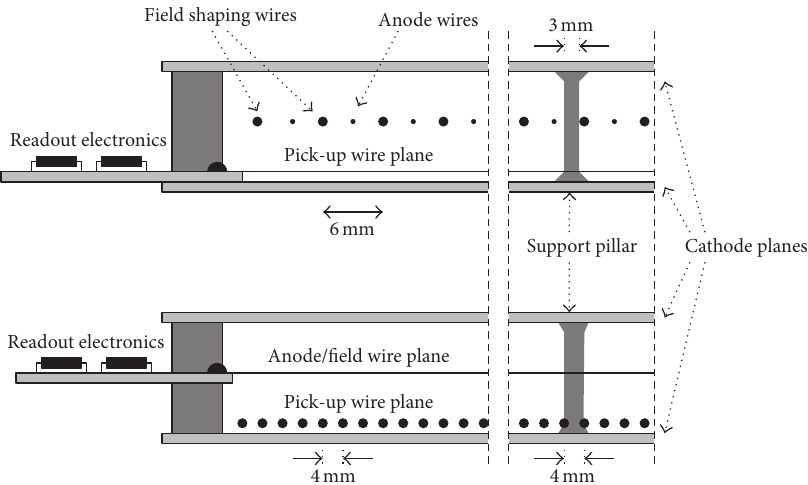
Figure 1: Cross section of the detector close to the side showing wire fixing, in both directions (perpendicularly to and parallel with the anode wires). The support pillar positioning between the wires is also